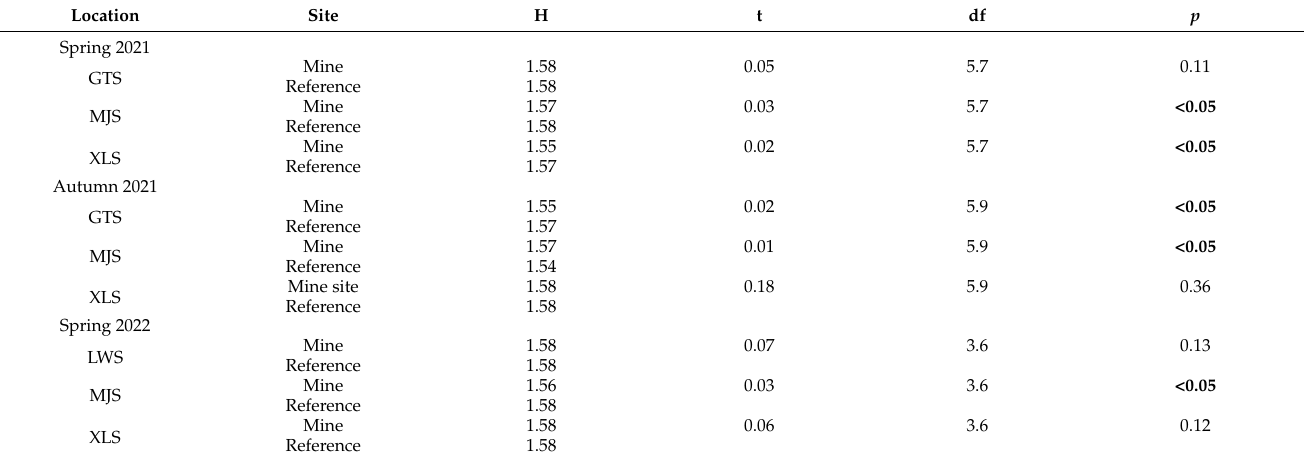
Table 6. Results from Hutcheson’s t -tests on the differences in plant diversity among mine versus reference sites (Shannon-Weiner index,